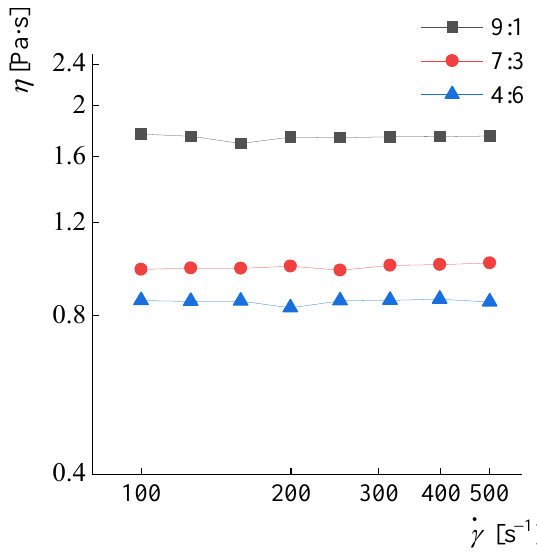
Figure A5. Flow curves of solvents used.